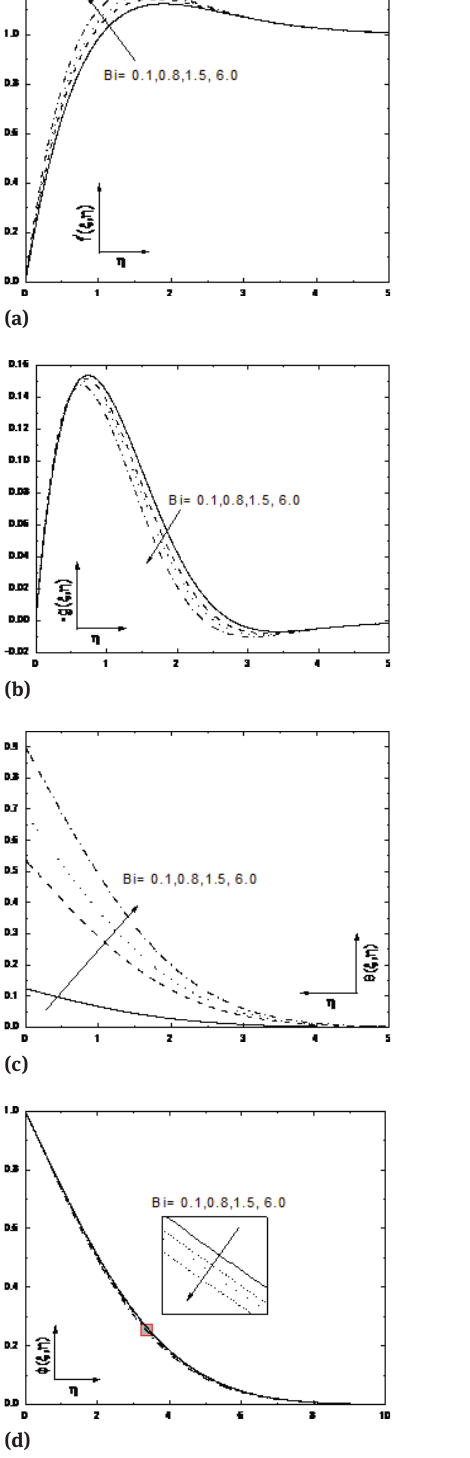
Fig. 4: Effect of Biot number on the (a) velocity, (b) microrotation, (c) temperature and (d) concentration for Δ = 1.0, Fs = 0.5, α 1 = 5, α 2 = 5, Ω = π /6, ξ = 0.5 .